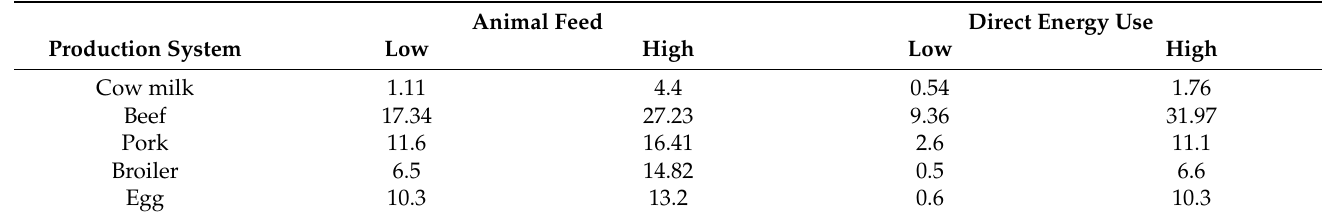
Table 1. Low and high range of energy inputs according to feed and direct energy inputs per